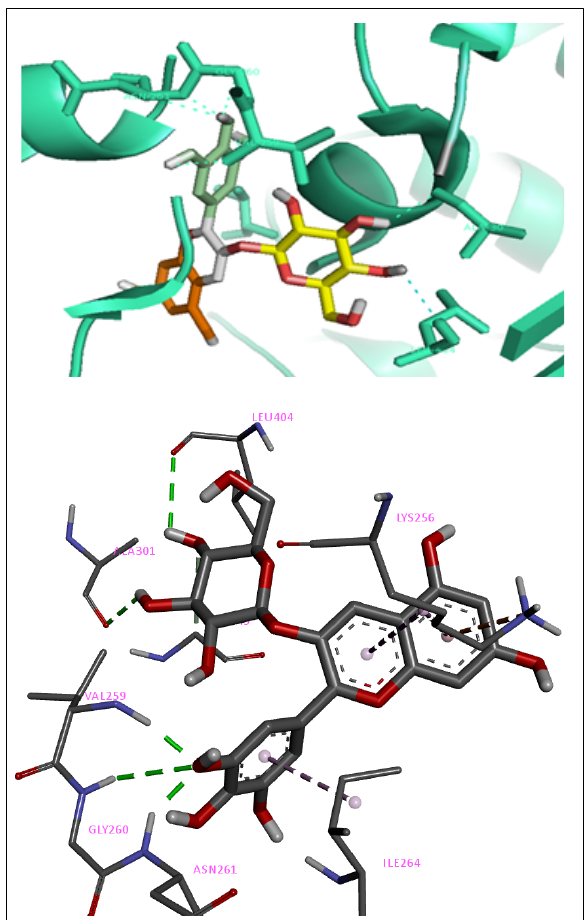
Figure 6: The different interactions: H-bonds π-alkyl, π-sigma and alkyl hydrophobic and electrostatic in cy-3-glu anthocyanin. Bonds are represented by dashed lines; classical H-bonds are in green; C-H bonds in grey, π-sigma dark violet, π-cation orange, π-alkyl violet, and alkyl faint violet.